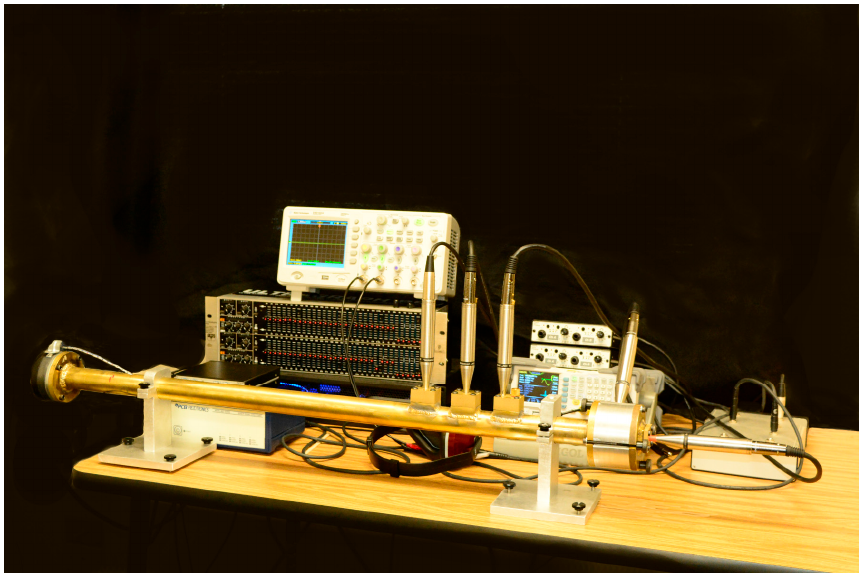
Figure 2. Picture showing the test apparatus utilized in the study. The apparatus has multiple upstream microphones for performing ISO 10534-2 as well as an insertion traveling microphone, attached to the cable seen entering the tube just to the right of the speaker on the far left of the tube. Seen on the far right of the tube is the silver aluminum sample holder that has a microphone embedded into the side wall to perform the sample surface pressure measurement: Iwase [12] microphone 0. At the far right is Iwase [12] transmission microphone 3 that is embedded in the end reflection-plate.